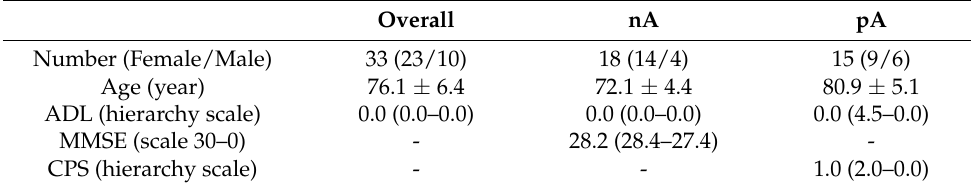
Table 1. Demographic and clinical characteristics of analyzed subjects’